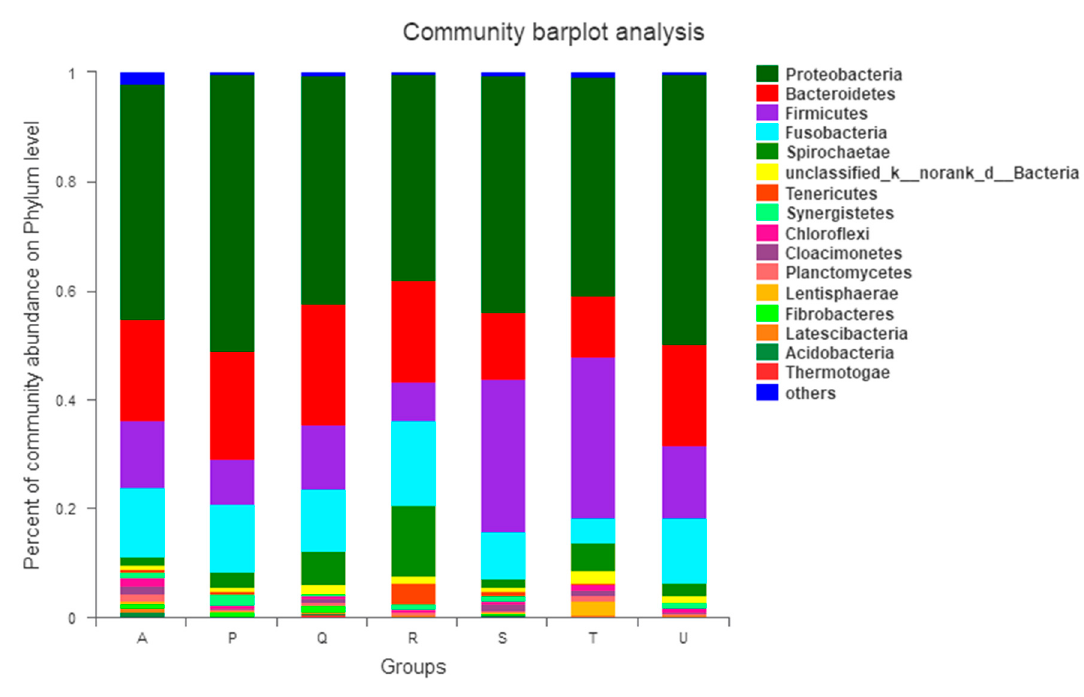
Figure 7. Comparison of the composition and relative abundance of di ff erent phyla of seven groups. The Group ID explanation is the same as that in the caption of Figure 6. “Others” indicates the sum of the relative percentages of phyla with their maximum abundance lower than 0.5% in any